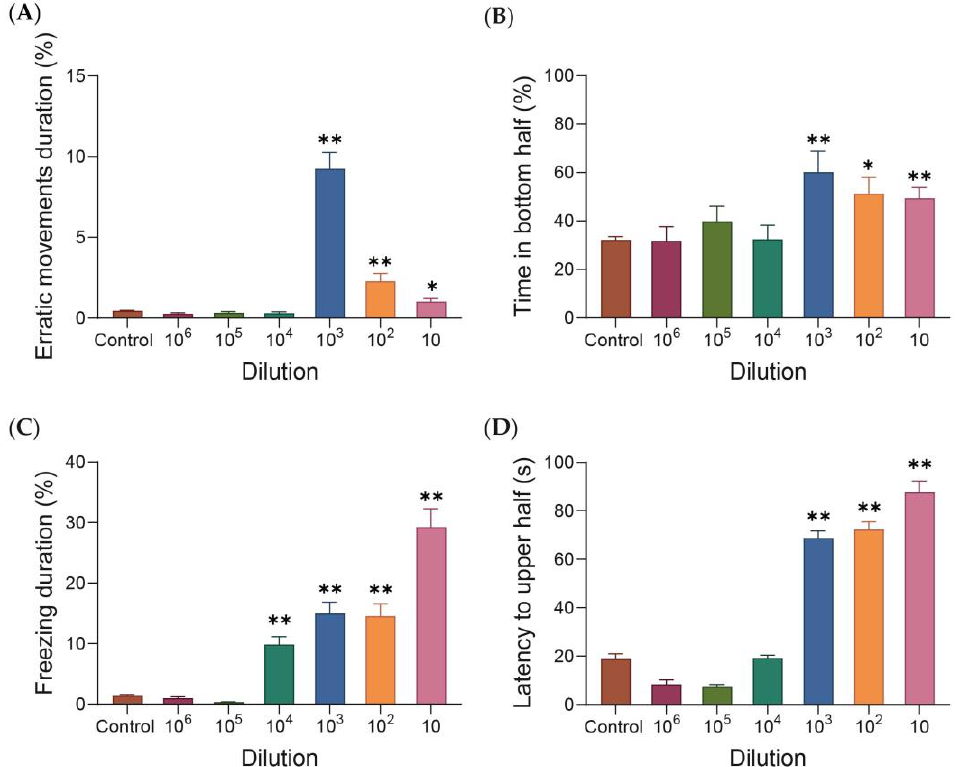
Figure 2. Zebrafish behavioral phenotypes, ( A ) erratic movements duration (%), ( B ) time in the bottom half (%), ( C ) freezing duration (%), and ( D ) latency to upper half (s), triggered by a serial dilution of the conspecific skin extract (stock solution equivalent with 0.5 fish/L, 10-fold dilution represented the equivalent concentration of 0.05 fish/L, and so on). Zebrafish treated with water in the aquarium were used as the control. Asterisks indicate significant differences between treatment and control (* P < 0.05, ** P < 0.01).